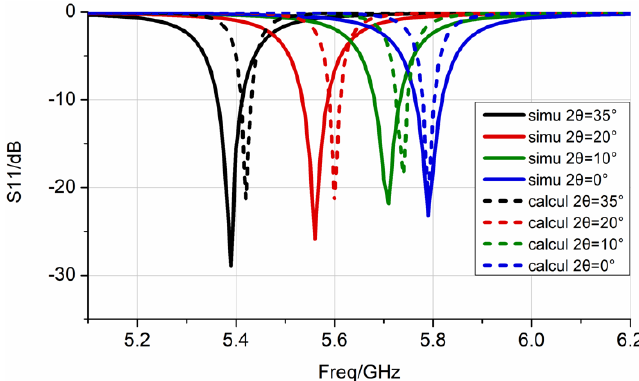
Figure 8. The S-parameters under different bending angles by full-wave simulation and equivalent circuit constructed are represented by solid and dashed lines, respectively.